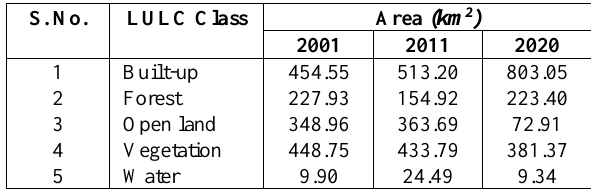
Table 2. Area of each class in the classified images of Delhi.